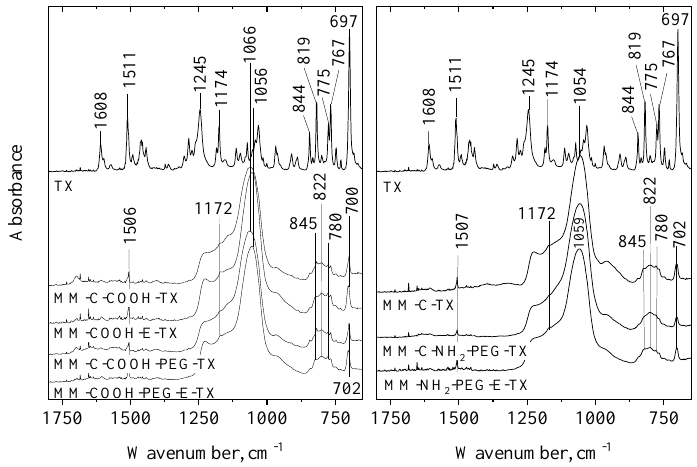
Figure 7. ATR FT-IR spectra of pure tamoxifen and tamoxifen-loaded MM and NH 2 -, COOH and PEGylated samples.